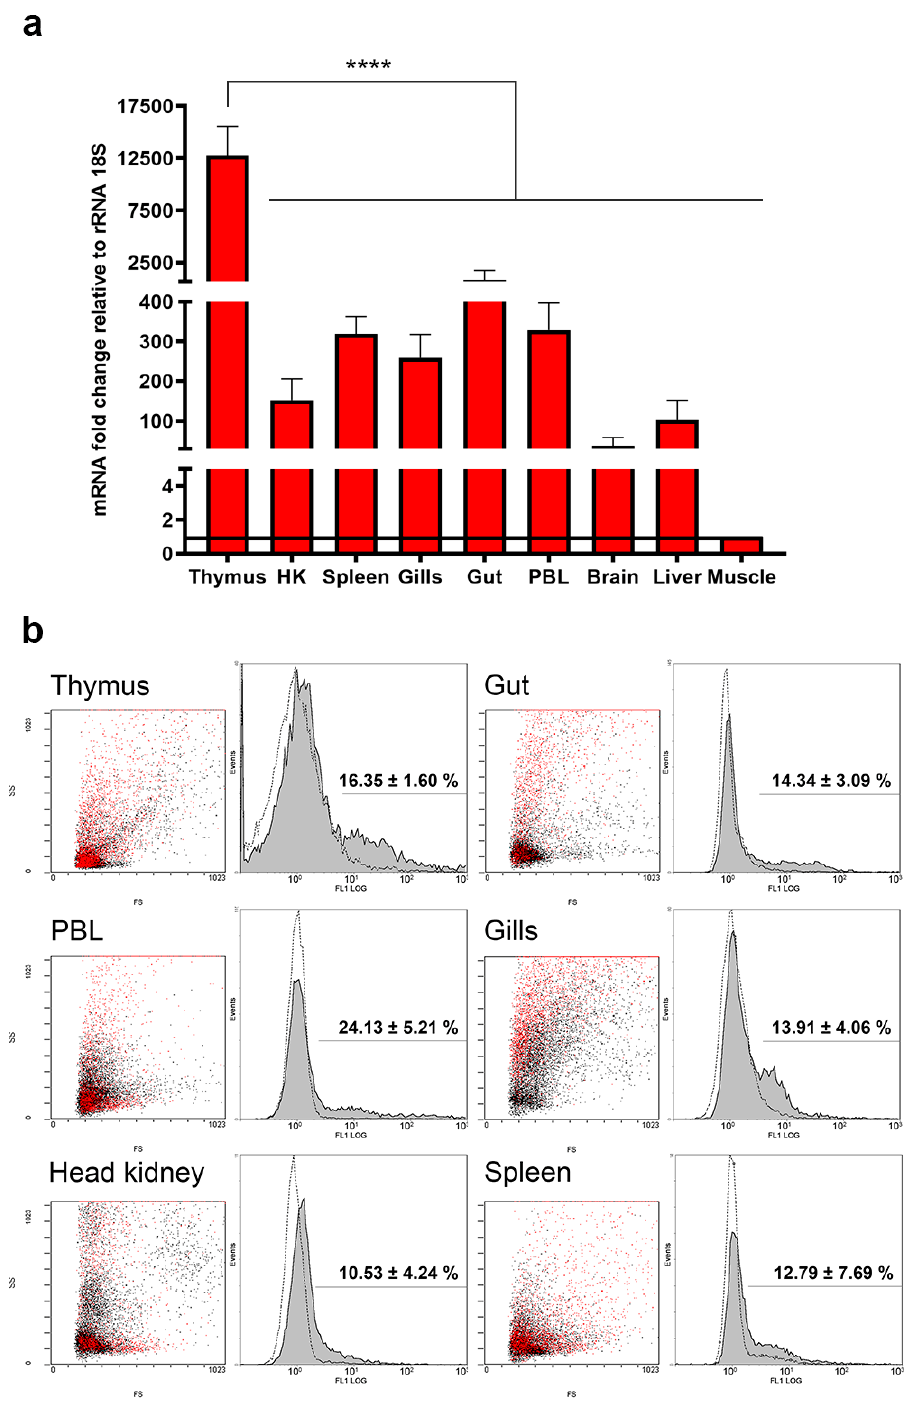
Figure 3. ( a ) Real-time qPCR of TR γ basal transcription levels in 1-year-old fish. mRNA fold change is expressed relatively to rRNA 18S as housekeeping gene. The muscle tissue was used as calibrator (i.e., tissue with the lowest relative expression of 1, highlighted by the straight horizontal line). Data is presented as mean + SD ( n = 3). **** : p < 0.0001. ( b ) Flow cytometry of leukocytes from 1-year-old fish incubated with RaTR γ 1 IgG at a 1:20 dilution in PBS. Red-colored events in the FS/SS dot-plots (left for each tissue) correspond to gated events in the FL1 histograms (right). Positivity percentage is presented as mean ± SEM ( n = 3) (gray peaks, solid line) net of pre-immune positivity (white peaks, dashed